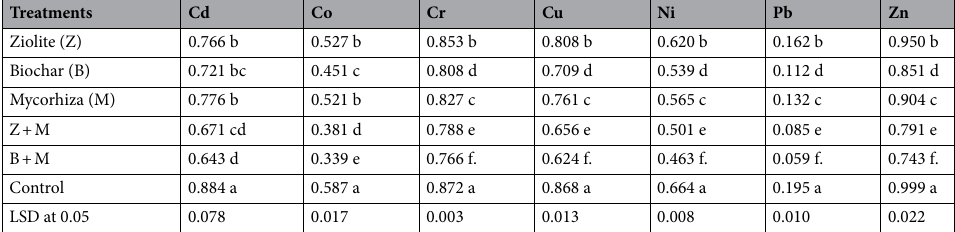
Table 2. Effect of soil amendments and mycorrhiza on bioconcentration factor (BCF) of cowpea plants grown in contaminated soil. Means followed with similar letters within the same column are not different significantly at P < 0.05 level of probability based on LSD test.